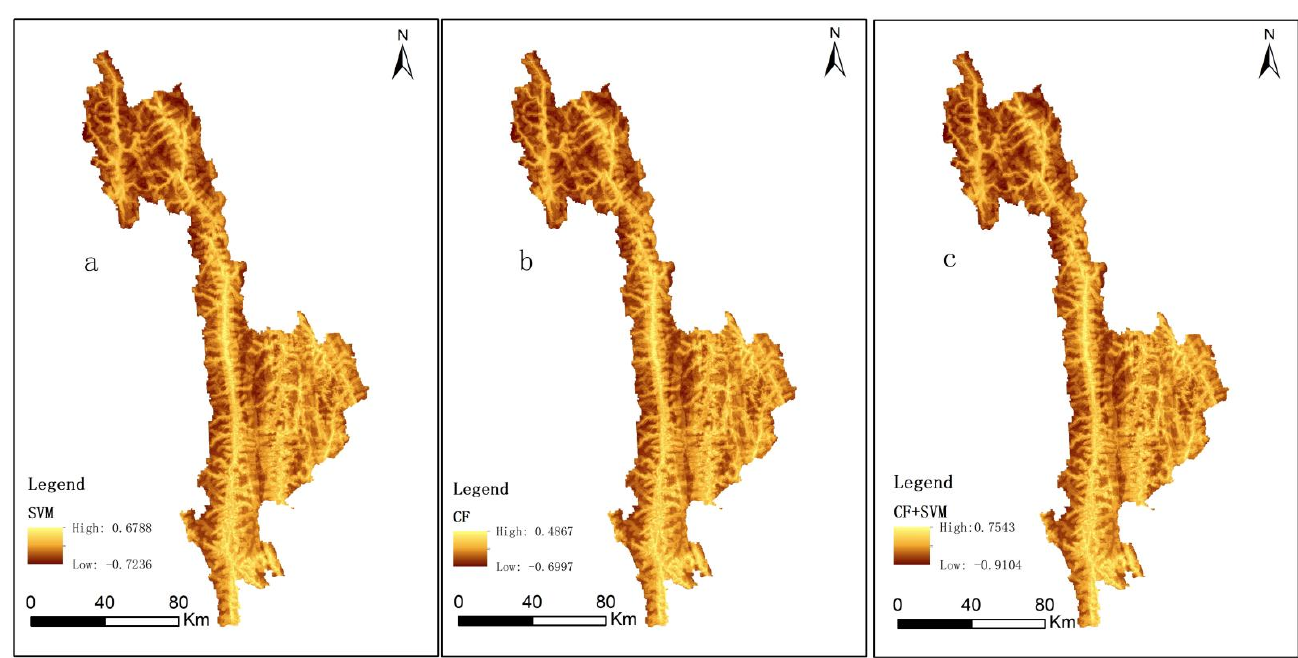
Figure 5. Slide susceptibility index diagram.